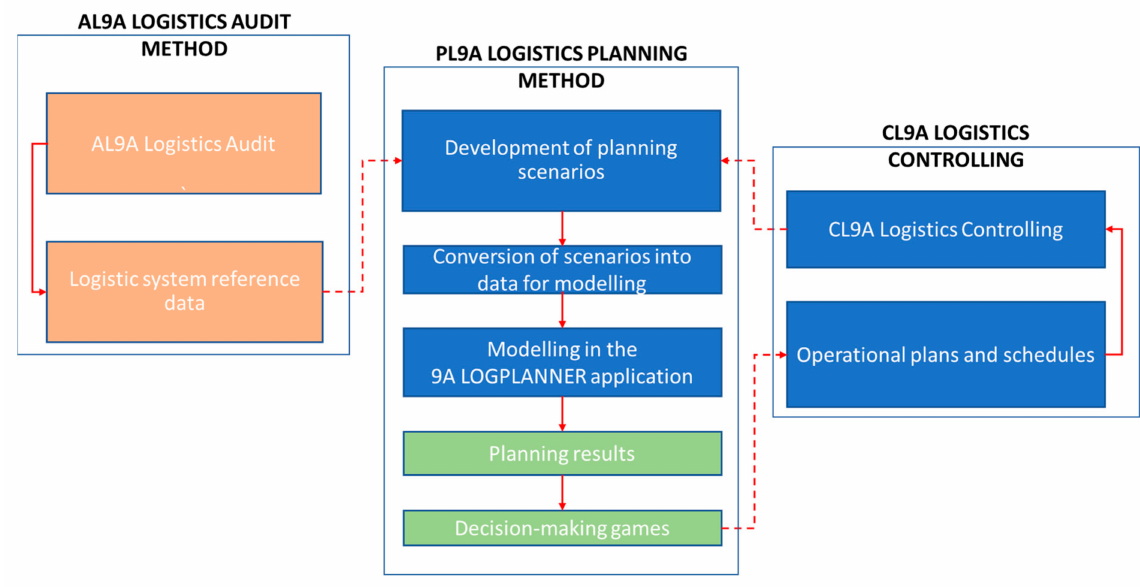
Figure 4. Comprehensive logistics planning according to PL9A